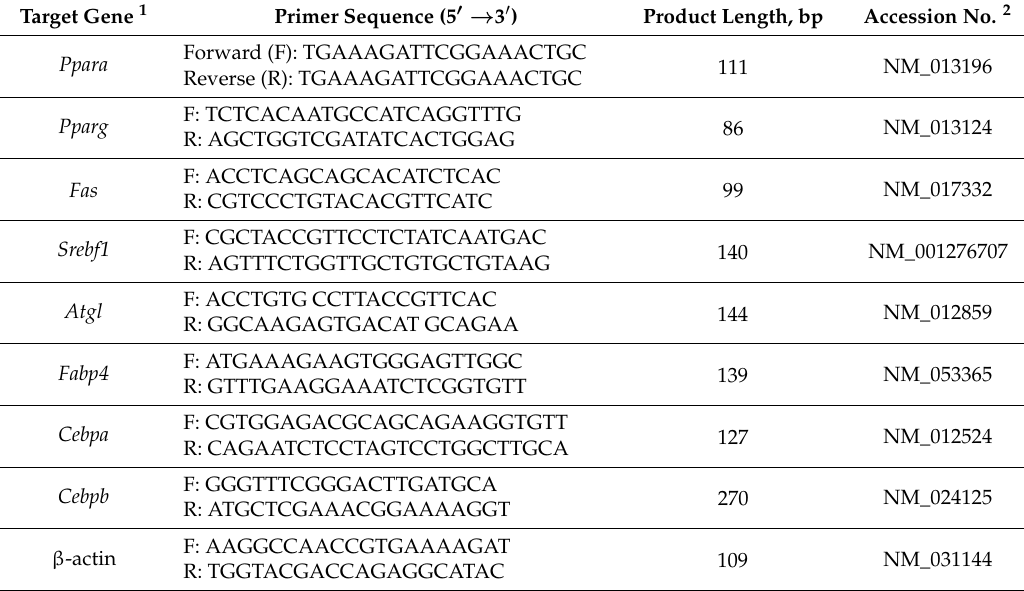
Table A3. Primer sequences for amplification of target